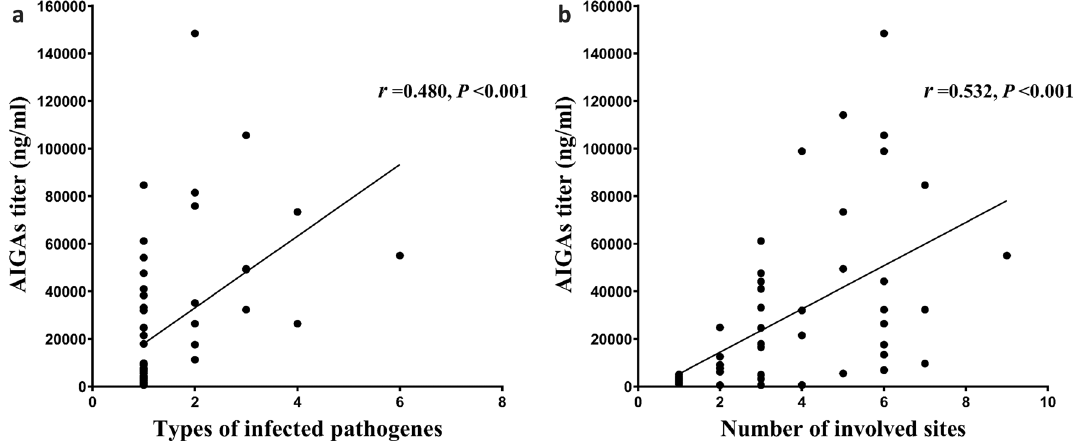
Figure 1. Pearson correlation analysis among anti-IFN-γ autoantibodies, the number of infectious pathogens, and involved sites. P < 0.05.